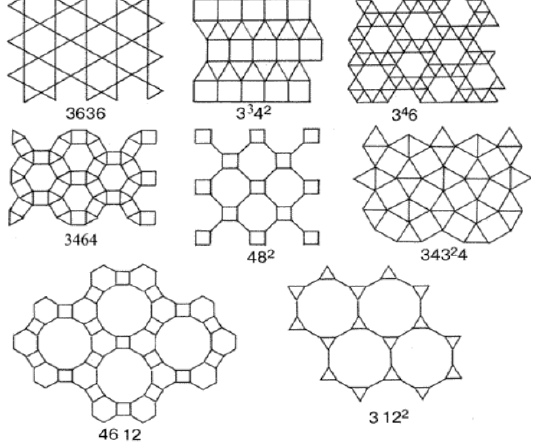
Figure 7. 11 Kepler nets.